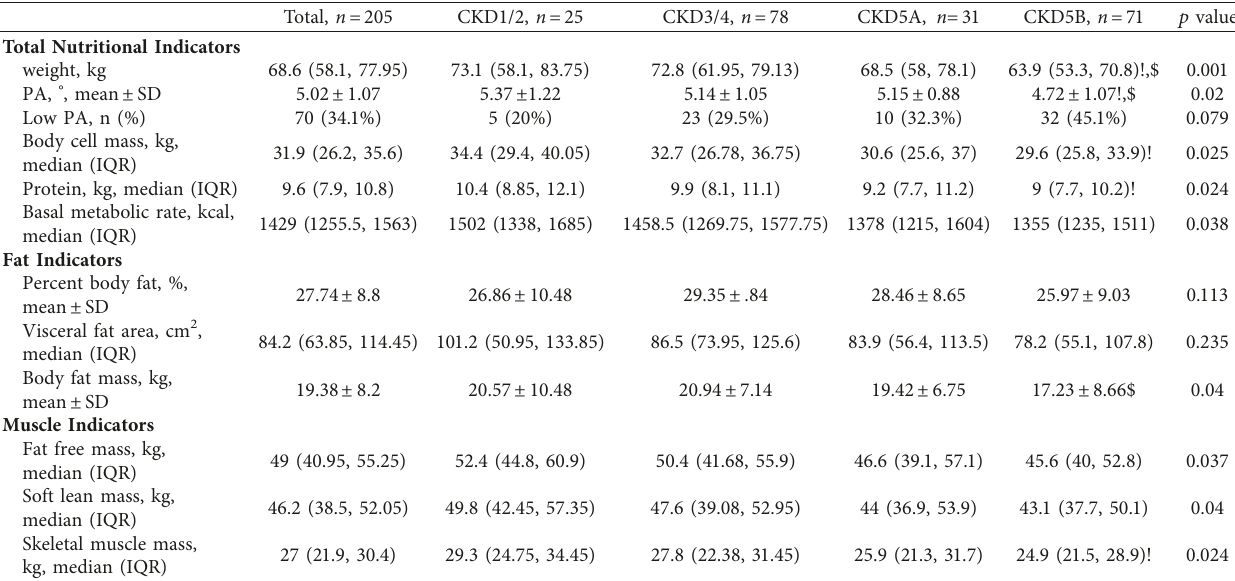
Table 2: Nutritional indicators of different CKD stage